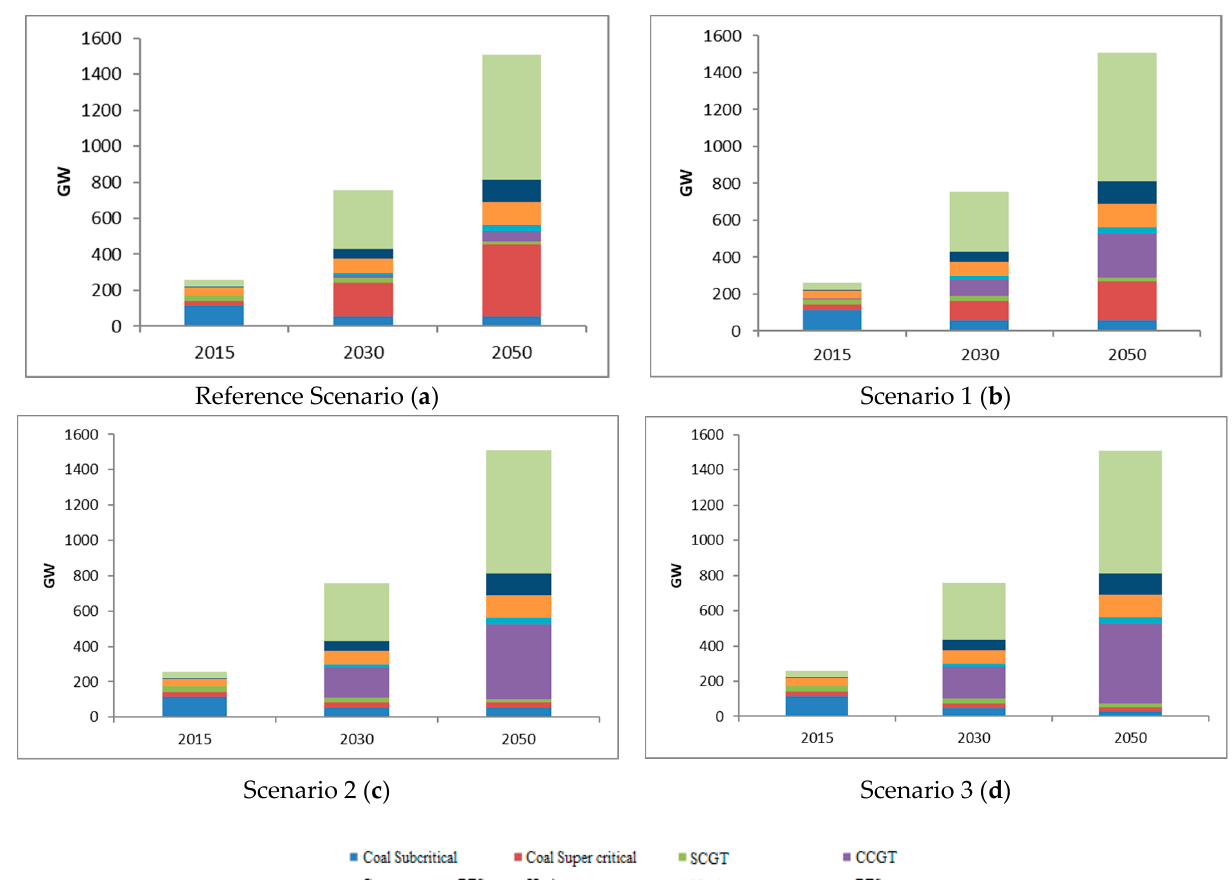
Figure 1. The installed capacity by technologies and fuels under different scenarios.